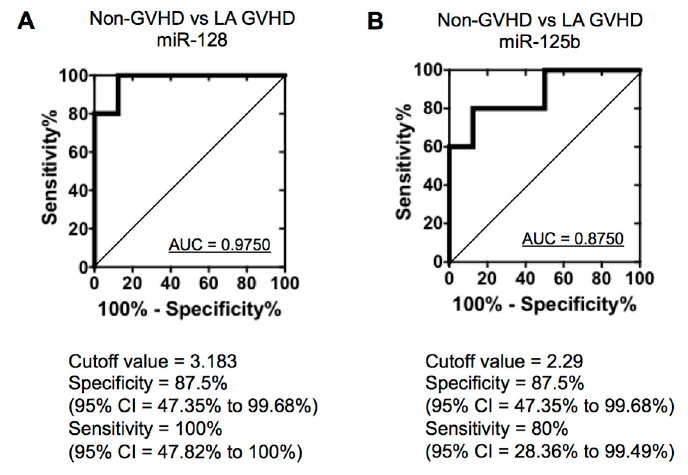
Figure 5. Association between exosomal miRNA and late-onset acute GVHD. ( A ) ROC curve for the identification of patients with late-onset acute GVHD versus non-GVHD using miR-128. ( B ) ROC curve for the identification of patients with late-onset acute GVHD versus non-GVHD using miR-125b.